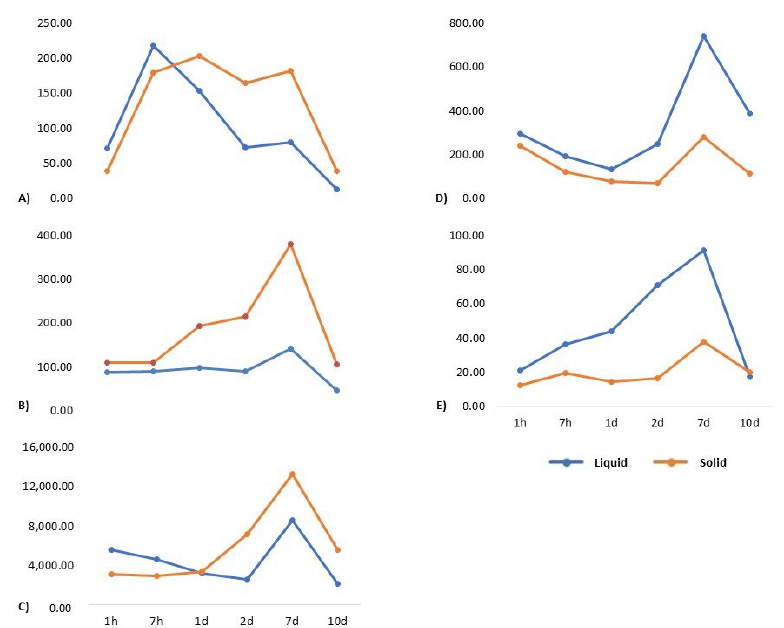
Figure 1. Growth factor release over time. Growth factor concentrations of liquid (blue) and solid (red) PRF over time for ( A ) EGF (pg/mL); ( B ) VEGF (pg/mL); ( C ) TGF β -1 (pg/mL); ( D ) PDGF-BB (pg/mL); and ( E ) MMP-9 (ng/mL).